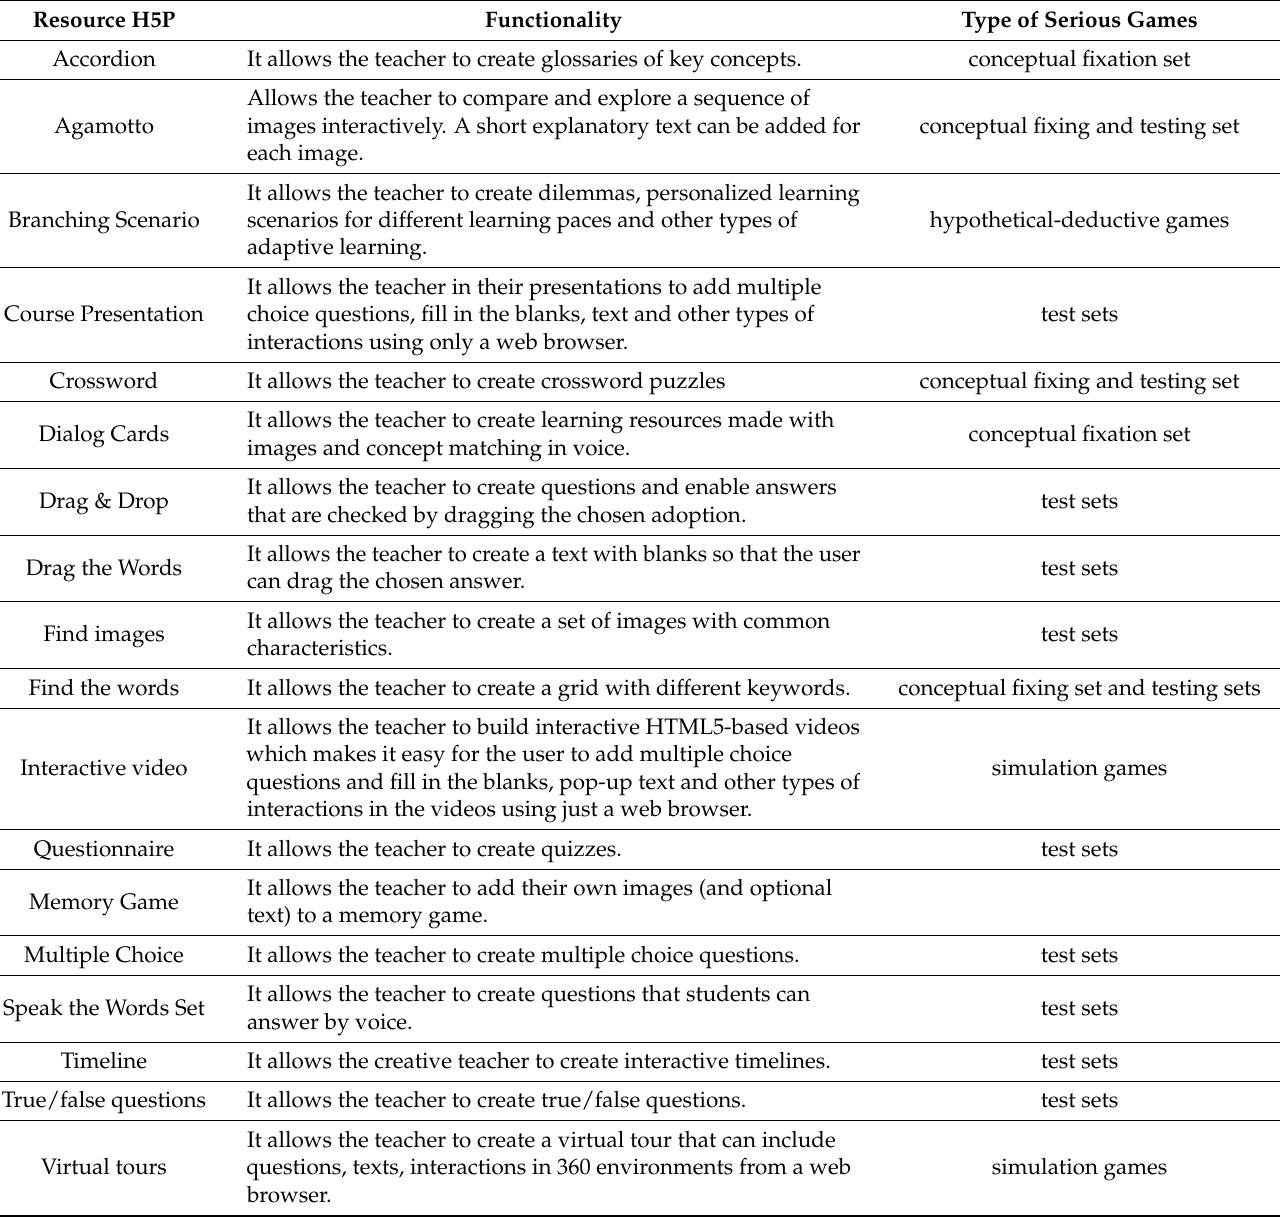
Table A1. H5P resources, functionality and type of DGBL.